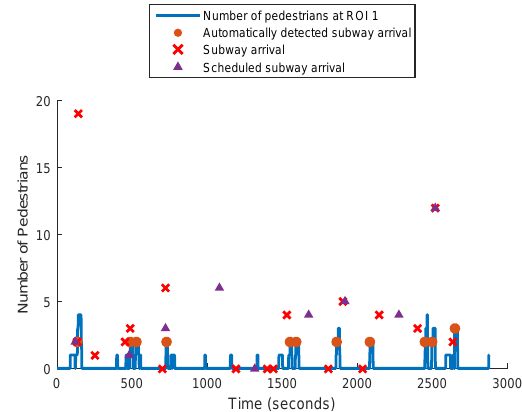
Figure 5: Sub-section of automatically detected number of pedes- trians for ROI #1 with automatically and manually detected sub- way arrivals.